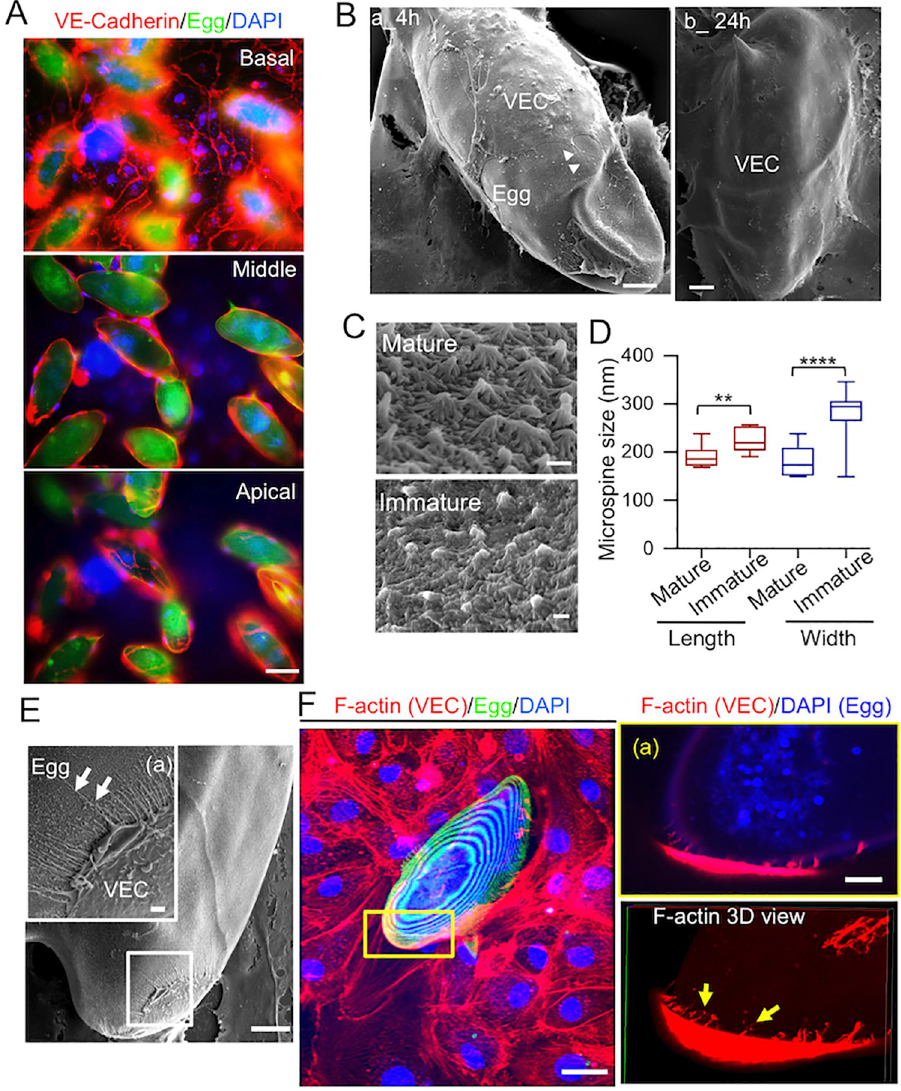
Fig 1. VECs generate filopodia while encapsulating S . mansoni eggs. (A) Immunostaining shows VECs (VE-Cadherin, red) on the basal, middle and apical areas of live S . mansoni mature eggs, which are auto-fluorescently green. DAPI was used to stain for cell nuclei. Scale bar: 50 μ m. (B) SEM images demonstrating the interaction between VECs and the eggshell: (a) At 4 h, part of an eggshell was covered by VECs (scale bar: 10 μ m), Arrowheads point VEC membrane protrusions on the eggshell; (b ) at 24 h, the eggshell was fully covered by VECs (scale bar: 10 μ m). (C) Image of microspines in mature and immature eggshells (scale bar: 0.2 μ m). (D) Quantification of the length and width of microspines in mature and immature eggshells. �� and ���� indicate respectively p < 0.01 and p < 0.0001 by Student’s t- test; 12–15 microspines were quantified in each condition. (E) SEM image of the interaction between the S . mansoni egg and VEC filopodia after 4 h (scale bar = 10 μ m); (a) enlarged image of the boxed region of interest showing VEC filopodia (arrows) on the eggshell surface. Scale bar: 1 μ m. (F) Confocal microscopy images of actin filaments. VECs and eggs were fixed, and immunostained with rhodamine phalloidin (red). Scale bar: 20 μ m. (a) Enlarged image of the boxed region of interest (showing the presence of VEC actin-rich filopodia during VEC encapsulation of the egg. Scale bar: 5 μ m. Lower panel is the 3D view and arrows indicate actin filaments on the eggshell surface. p < 0.0001). However, although the average length of filopodia and NTs per egg was not signif- icantly different (p > 0.05), being 4.78 ± 0.28 μ m and 5.96 ± 1.24 μ m, respectively (Fig 2C and